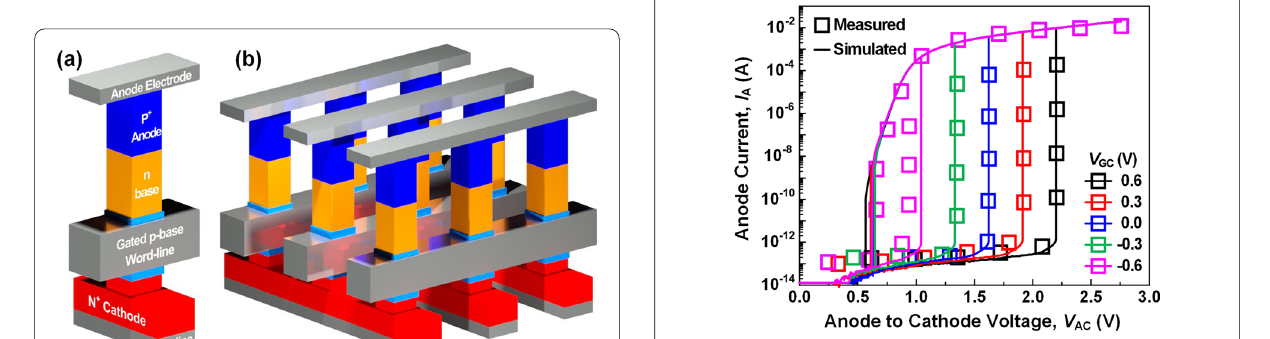
Fig. 1 Schematic diagrams of a 3‑T TRAM unit cell and b cross‑point vertical 3‑T TRAM array